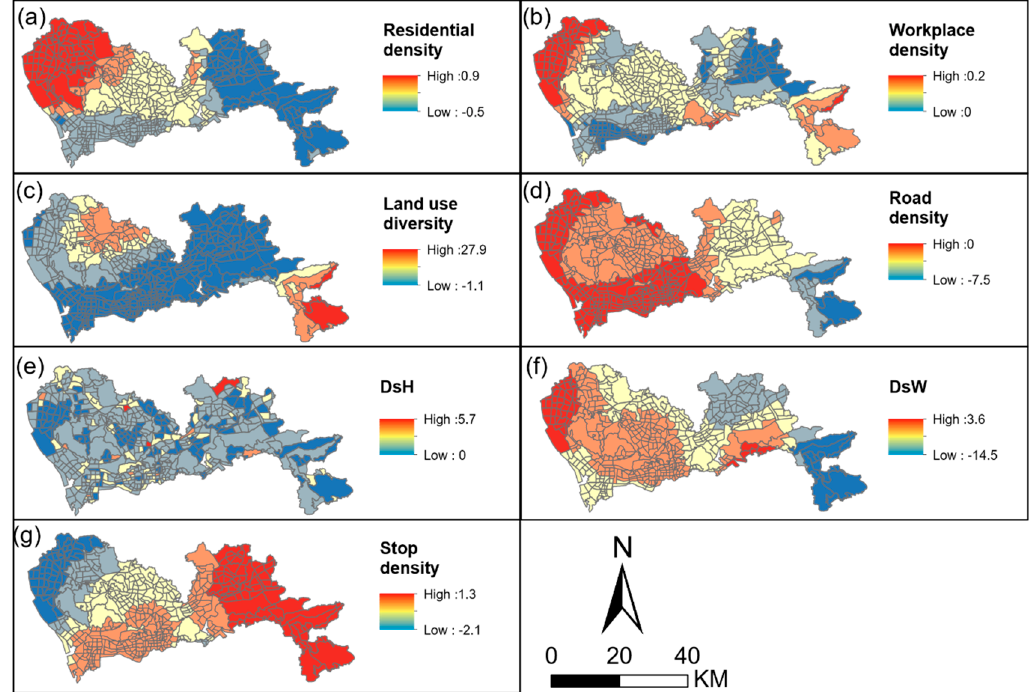
Figure 9. Local coefficients for bus ECI. ( a ) Residential density; ( b ) workplace density; ( c ) land use diversity; ( d ) road density; ( e ) distance between the nearest transit stop and home (DsH); ( f ) distance between the nearest transit stop and work (DsW); ( g ) stop density.